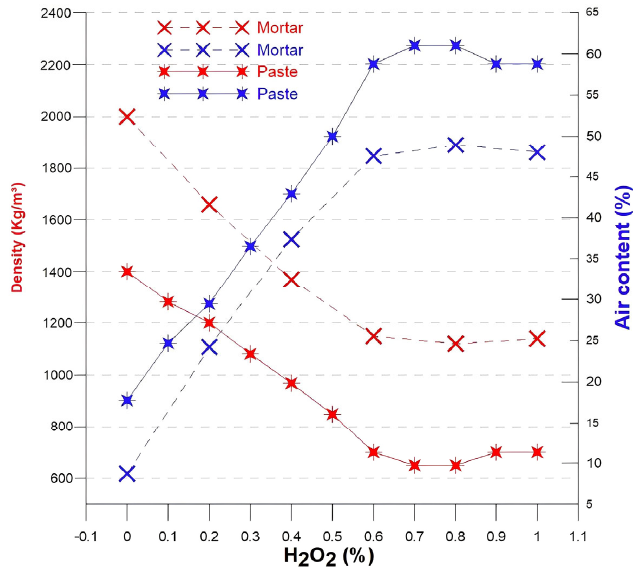
Figure 2. E ff ect of H 2 O 2 on the apparent density of pastes and mortars. Figure 2. Effect of H 2 O 2 on the apparent density of pastes and